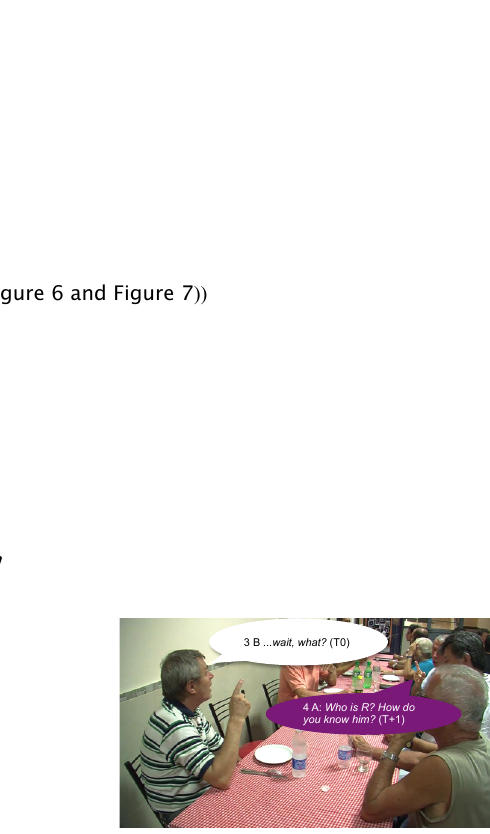
Figure 7. ‘Wait, what?’ , Person B, also in line 3, after raising his eyebrows and head at the beginning of line 3, opens his mouth (OM) and raises his index finger